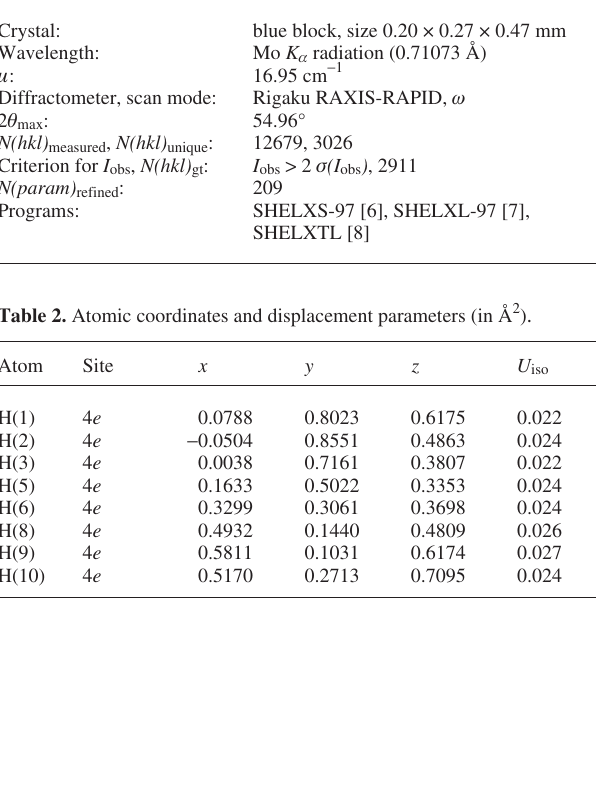
Table 1. Data collection and handling.